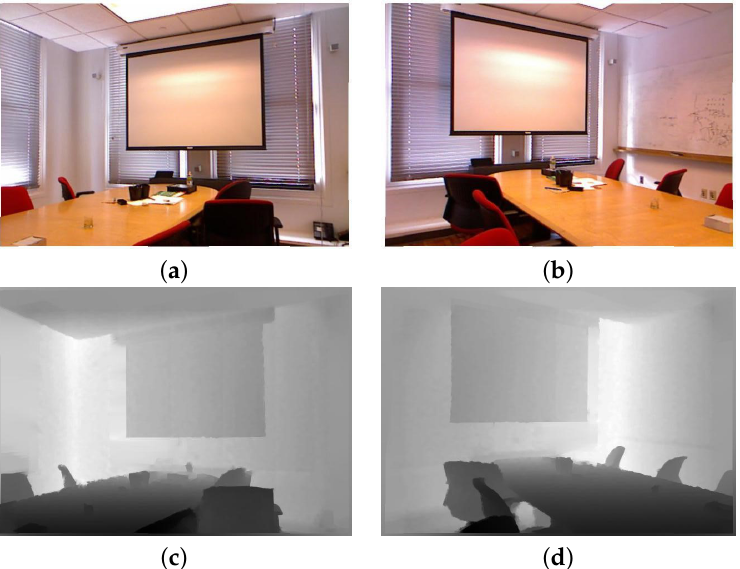
Figure 9. The RGB image of the second pair and their depth images: ( a ) original RGB image numbered 25; ( b ) original RGB image numbered 26; ( c ) depth image of ( a ); ( d ) depth image of ( b